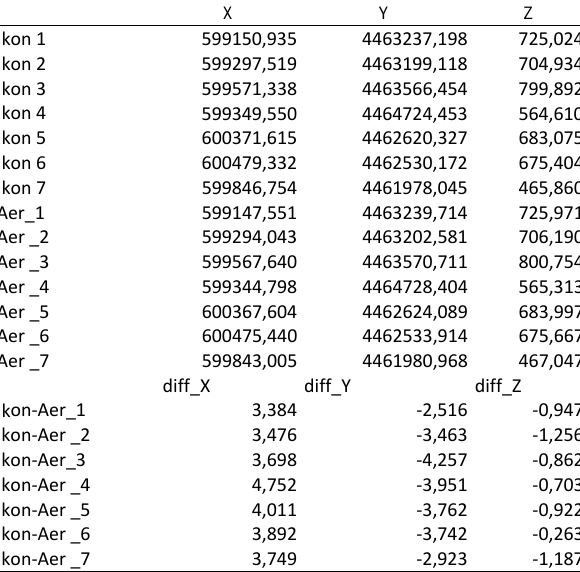
Table 1 Control points without GCP.